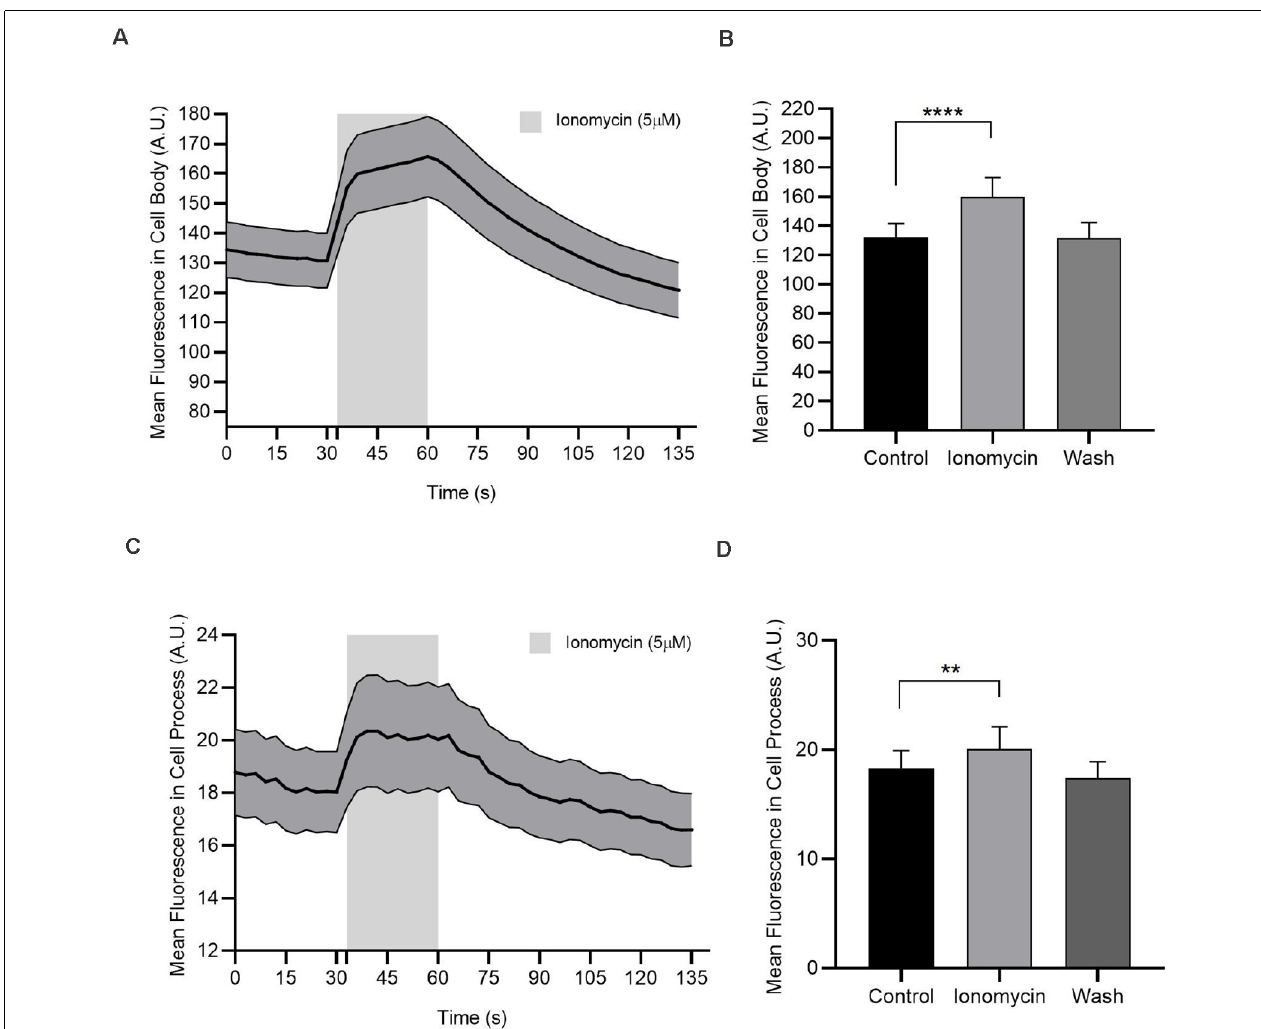
FIGURE 7 | In the absence of extracellular Ca 2+ , ionomycin releases Ca 2+ from internal stores. Calcium imaging experiments of AC cell body and cell process are loaded with Oregon Green BAPTA-1 488-AM. (A) Ionomycin (5 µ M) increases cytosolic Ca 2+ in the cell body. (B) The quantified mean fluorescence ± SEM; n = 73. **** P < 0.0001 (paired t -test). (C) Ionomycin (5 µ M) increases cytosolic Ca 2+ in the cell process. (D) The quantified mean fluorescence ± SEM; n = 58. ** P < 0.01 (paired t